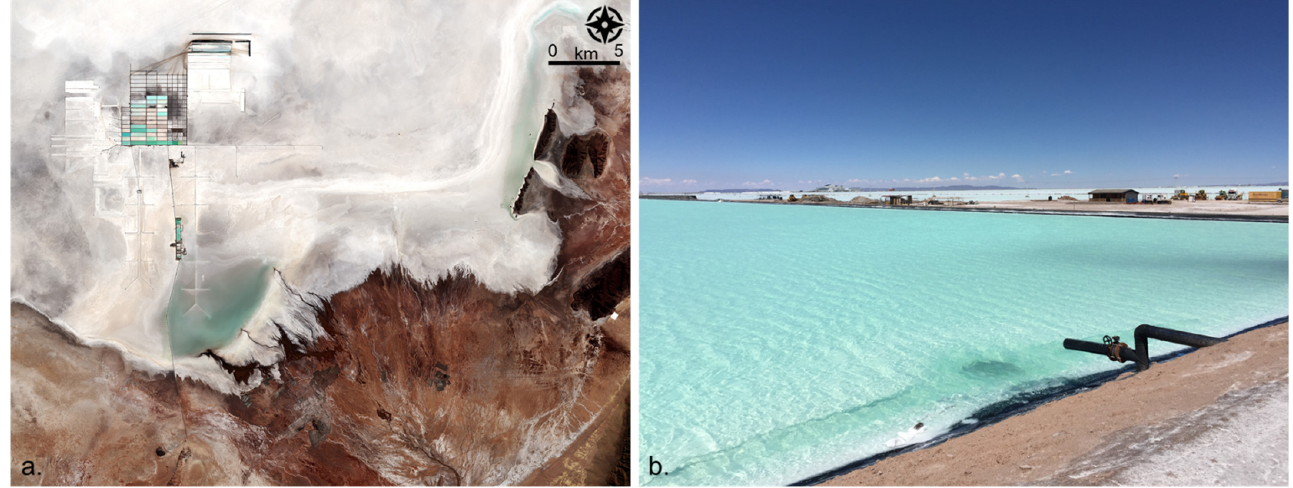
Figure 1. ( a ) Aerial view of lithium ponds at the Salar de Uyuni, Bolivia (© contains modified Copernicus Sentinel data (2017), processed by ESA, CC BY-SA 3.0 IGO); ( b ) view across the ponds, of about 1 km width (© UK Research and Innovation (UKRI)/British Geological Survey (BGS)).